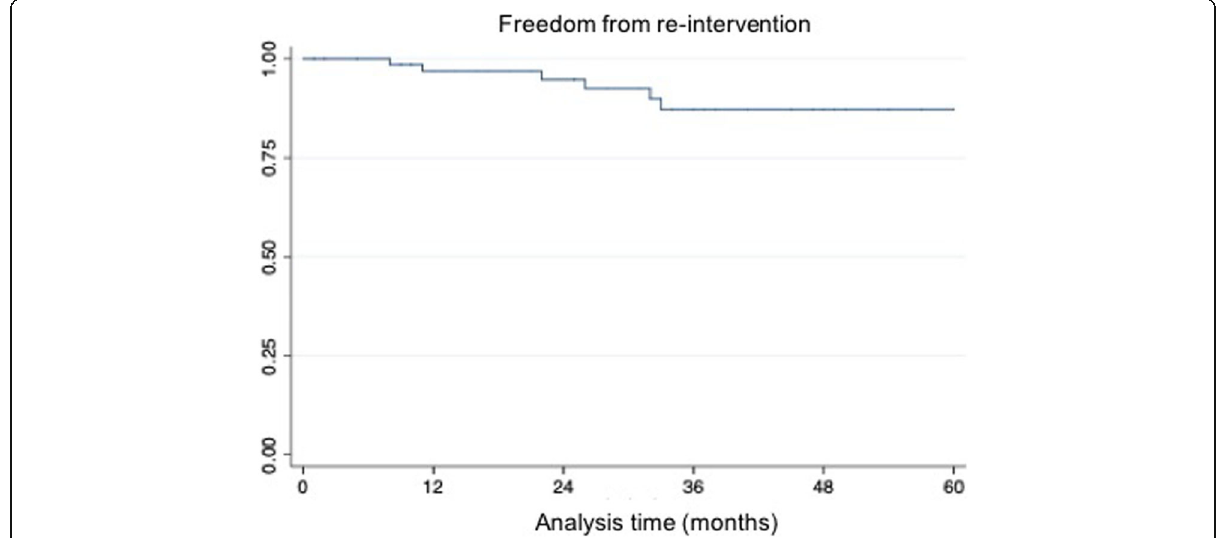
Fig. 2 Freedom from re-intervention according to Kaplan-Meier